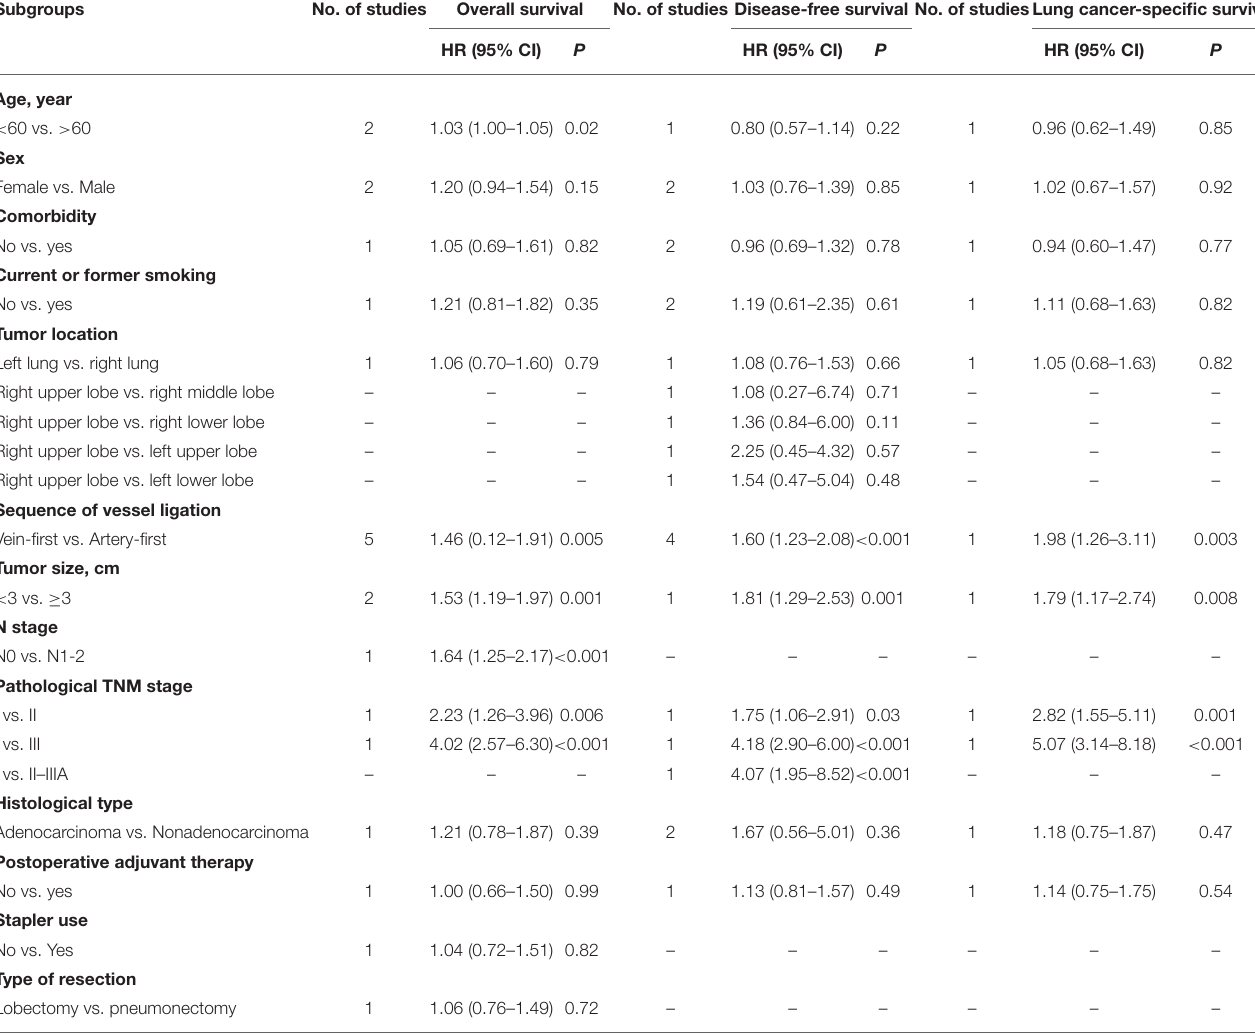
TABLE 2 | Subgroup analysis of survival (OS, DFS, and LCSS) in NSCLC patients after lobectomy.